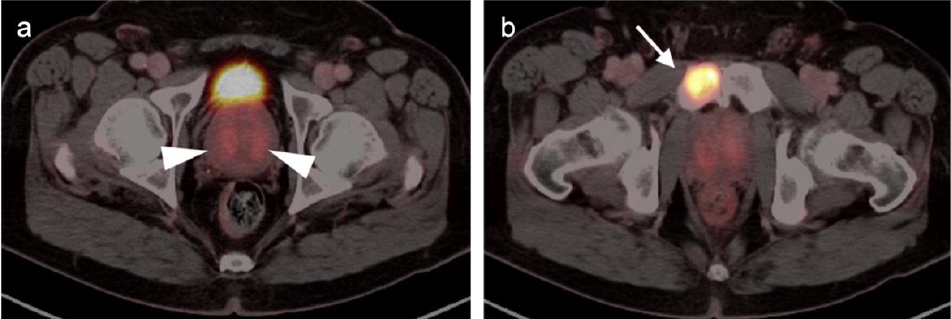
Figure 28. Discordant uptake between primary tumor and metastatic prostate cancer on [ 18 F]-DCFPyL (PSMA) PET-CT. ( a ) The primary tumor was Grade Group 3 in the transitional zone of both lobes of the prostate, corresponding to the regions of mild uptake on PMSA PET-CT (white arrowheads). There is less activity on PMSA PET-CT than would normally be expected for unknown reasons. The patient had not received ADT; ( b ) a metastasis to the right pubic bone (white arrow) is intensely PET positive, in comparison to the primary tumor.